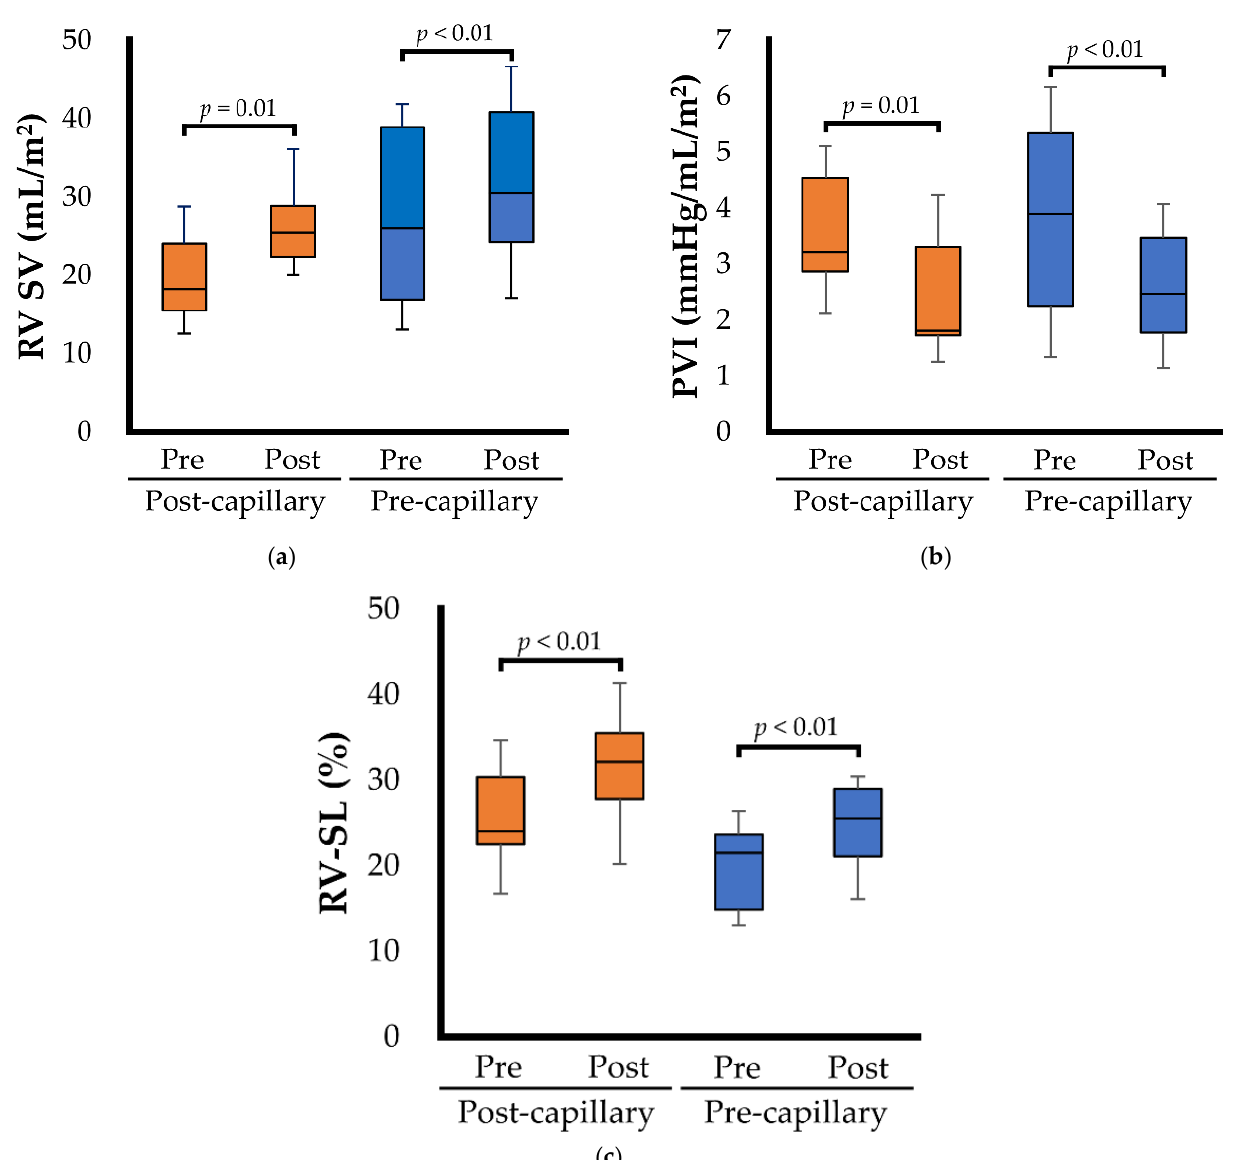
Figure 2. Box and whisker plots showing the specific right heart hemodynamics and functional echocardiographic variables before (Pre) and after (Post) beraprost sodium administration. The bottom of the box is 25th percentile, the center line is the median, the top of the box is 75th percentile, and the whiskers are the range. The blue box represents the results for dogs with pre-capillary pul- monary hypertension; the orange box represents the results for dogs with post-capillary pulmonary hypertension. ( a ) Right ventricular stroke volume (RV SV); ( b ) Pulmonary vascular impedance (PVI); ( c ) Right ventricular longitudinal strain (RV-SL).